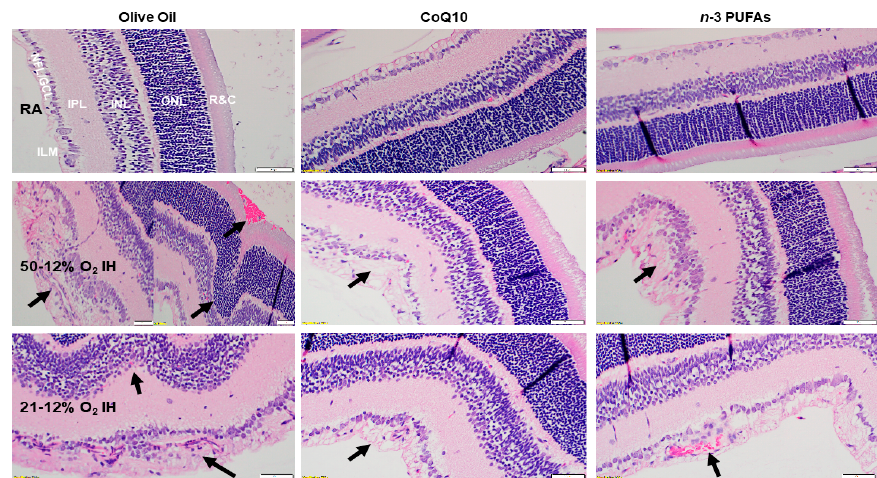
Figure 8. Representative Hematoxylin & eosin (H&E) stained images of retinas from 21-day-old rat exposed to RA ( top panels ), 50/12% O 2 IH ( middle panels ), and 21/12% O 2 IH ( lower panels ). Animals were supplemented with olive oil ( left panels ), CoQ10 ( middle panels ), or n -3 PUFAs ( right panels ). The images show retinal layer integrity and number of endothelial cells in the nerve fiber layer (NFL)/ganglion cell layer (GCL). The layers are identified in the RA-exposed, olive oil-treated animal. ILM (inner limiting membrane); IPL (inner plexiform layer); INL (inner nuclear layer); ONL (outer nuclear layer); and R&C (rods and cones). Images are 40× magnification, and the scale bar is 50 µM. Table 5. Retinal Morphometry at P21.